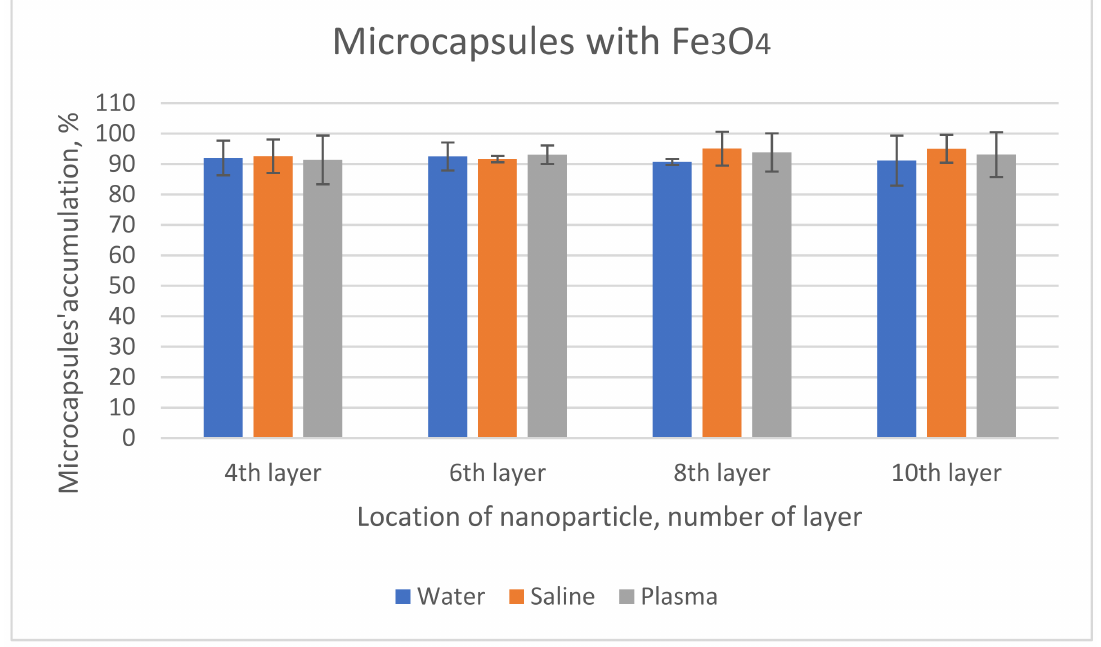
Figure 5. Accumulation of microcapsules with Fe 3 O 4 ,